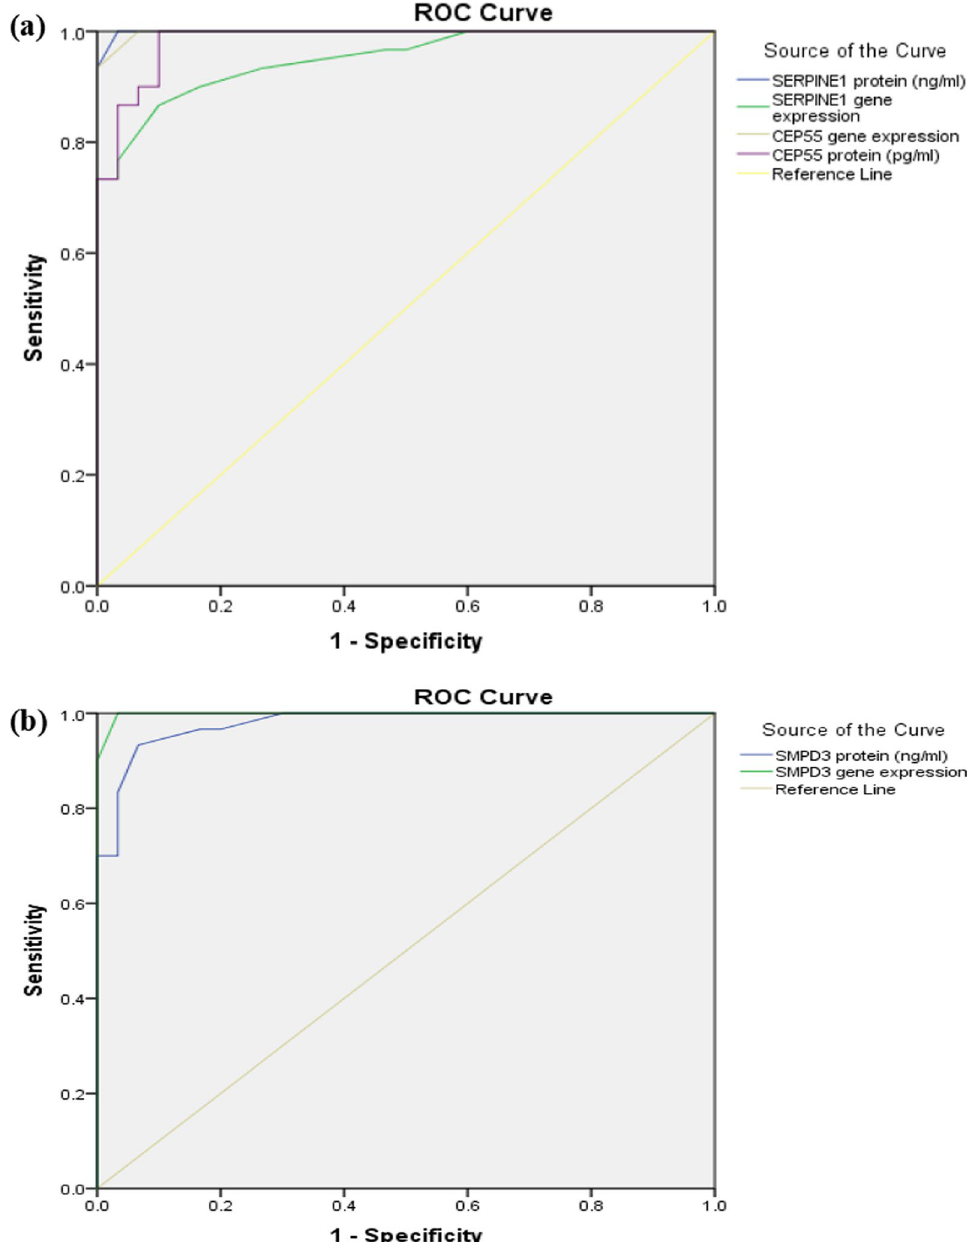
Fig. 2 ROC curve analysis of the studied parameters in the prediction of the presence of gastric carcinoma. a ROC curve analysis of SERPINE1 gene, protein, CEP55 gene and protein in the prediction of the presence of gastric carcinoma. b ROC curve analysis of SMPD3 gene and protein in